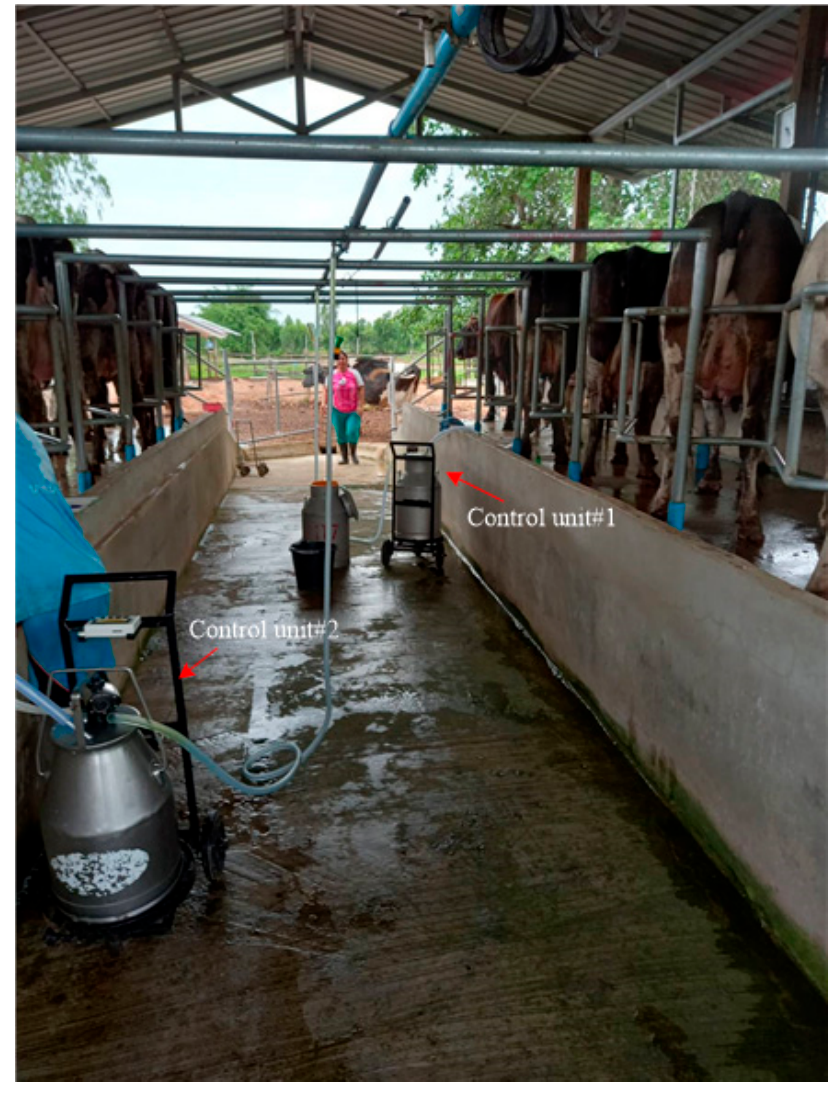
Figure 10. Milking stall used in experiments.